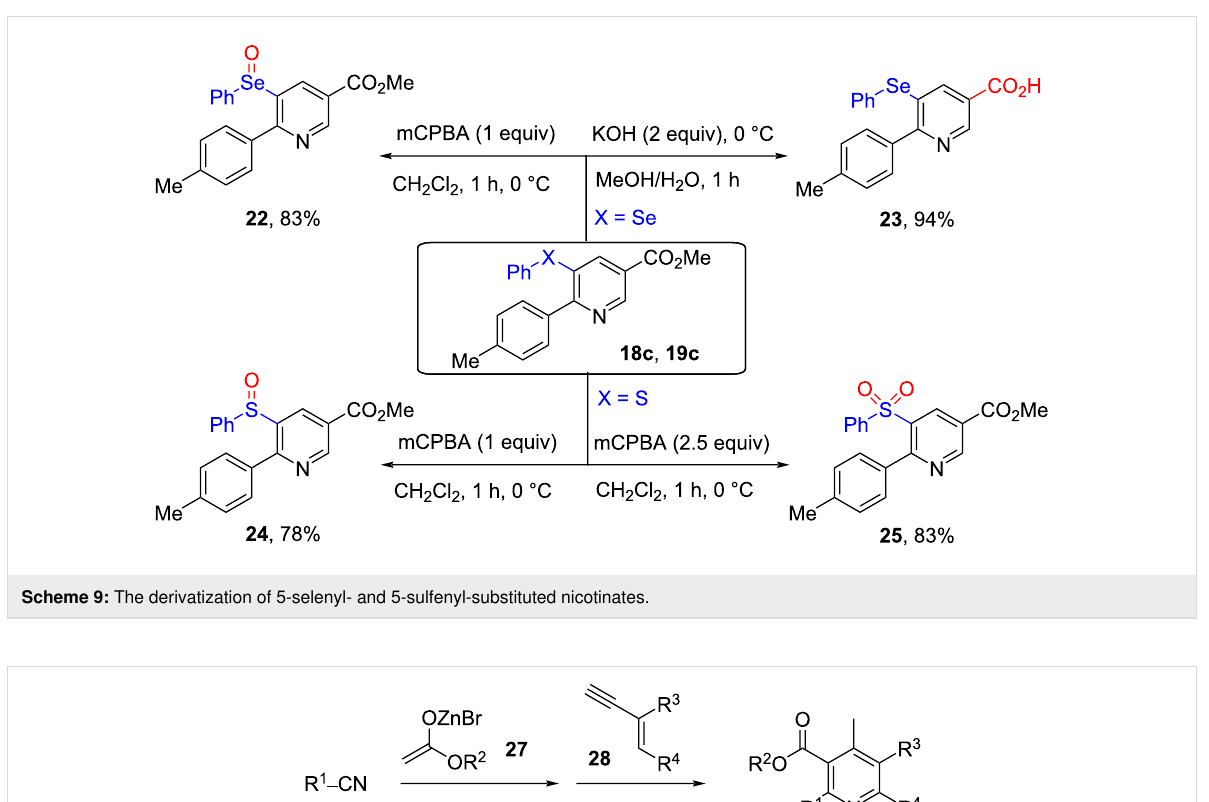
Scheme 9: The derivatization of 5 ‑ selenyl- and 5-sulfenyl-substituted nicotinates.